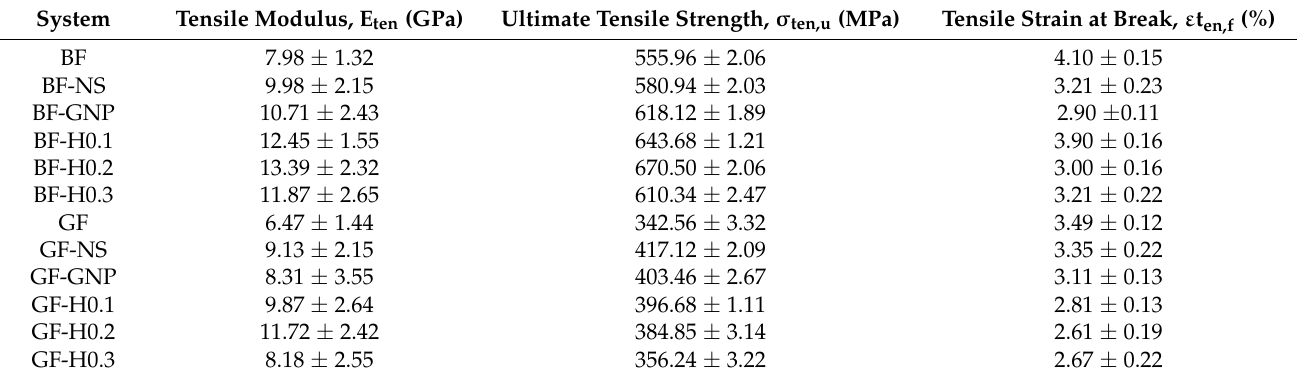
Figure 3. Typical tensile stress-strain response of GFRP and BFRP embedded with hybrid nanofiller. Table 4. Tensile properties of FRP embedded with hybrid nanofiller.